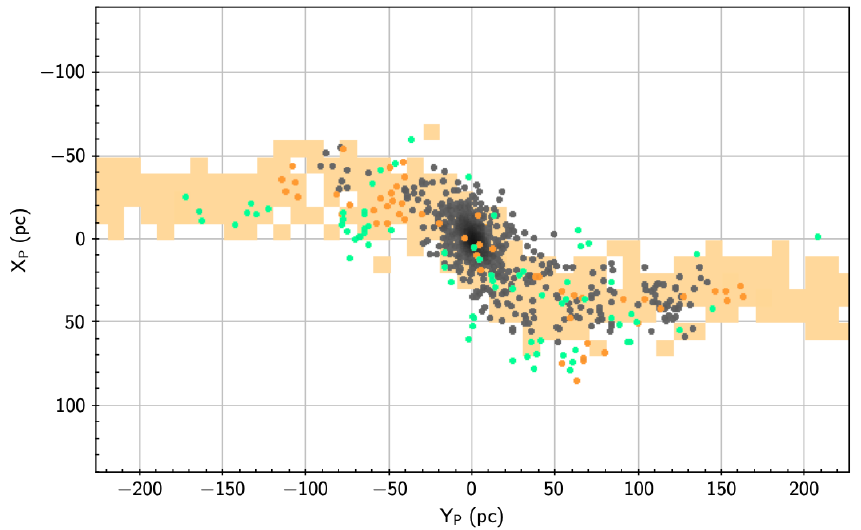
Figure 8. Members of the Praesepe cluster (NGC 2632) identified by Röser and Schilbach [221], displayed in Cartesian Galactic coordinates centred on the cluster. The grey, orange, and cyan points are secure, likely, and possible members of the cluster (respectively). The shaded background is the tidal tail model from Kharchenko et al. [230]. Credit: Röser and Schilbach [221], A&A, 627 (2019) A4, reproduced with permission ©